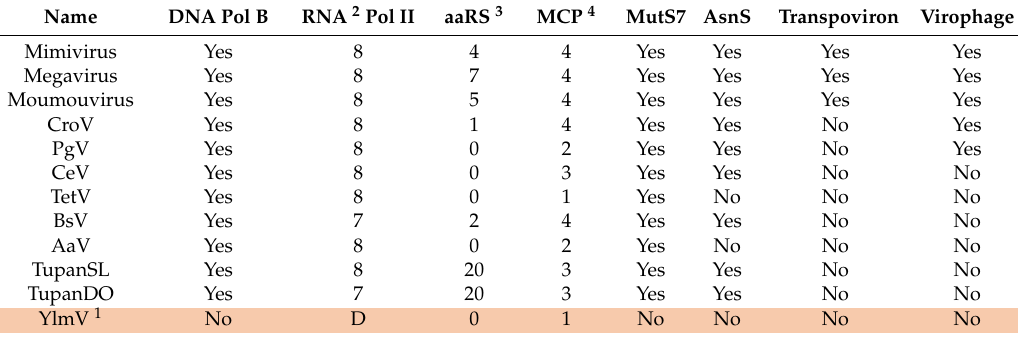
Table 3. Characteristic features of various